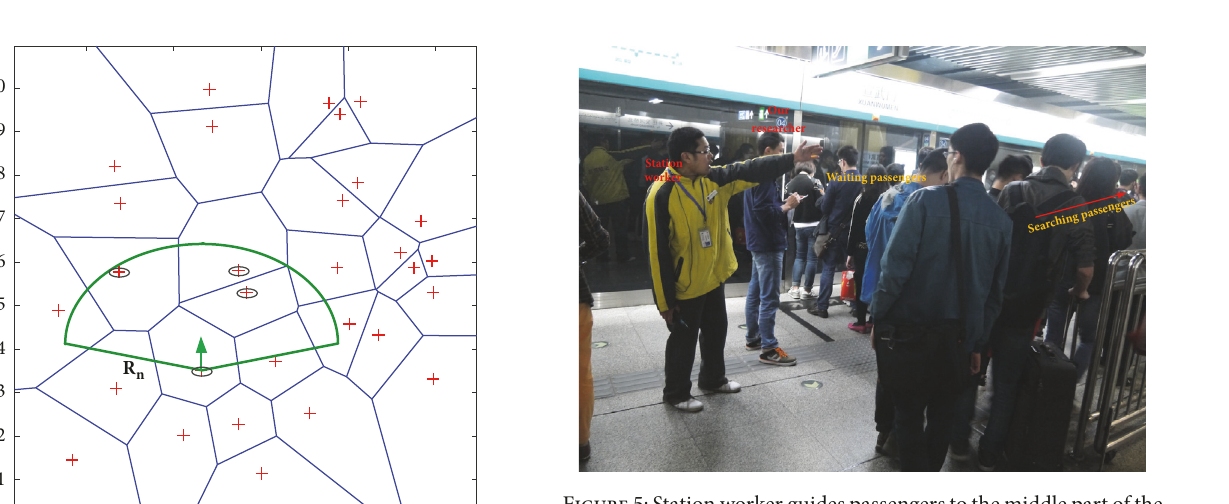
Figure 5: Station worker guides passengers to the middle part of the